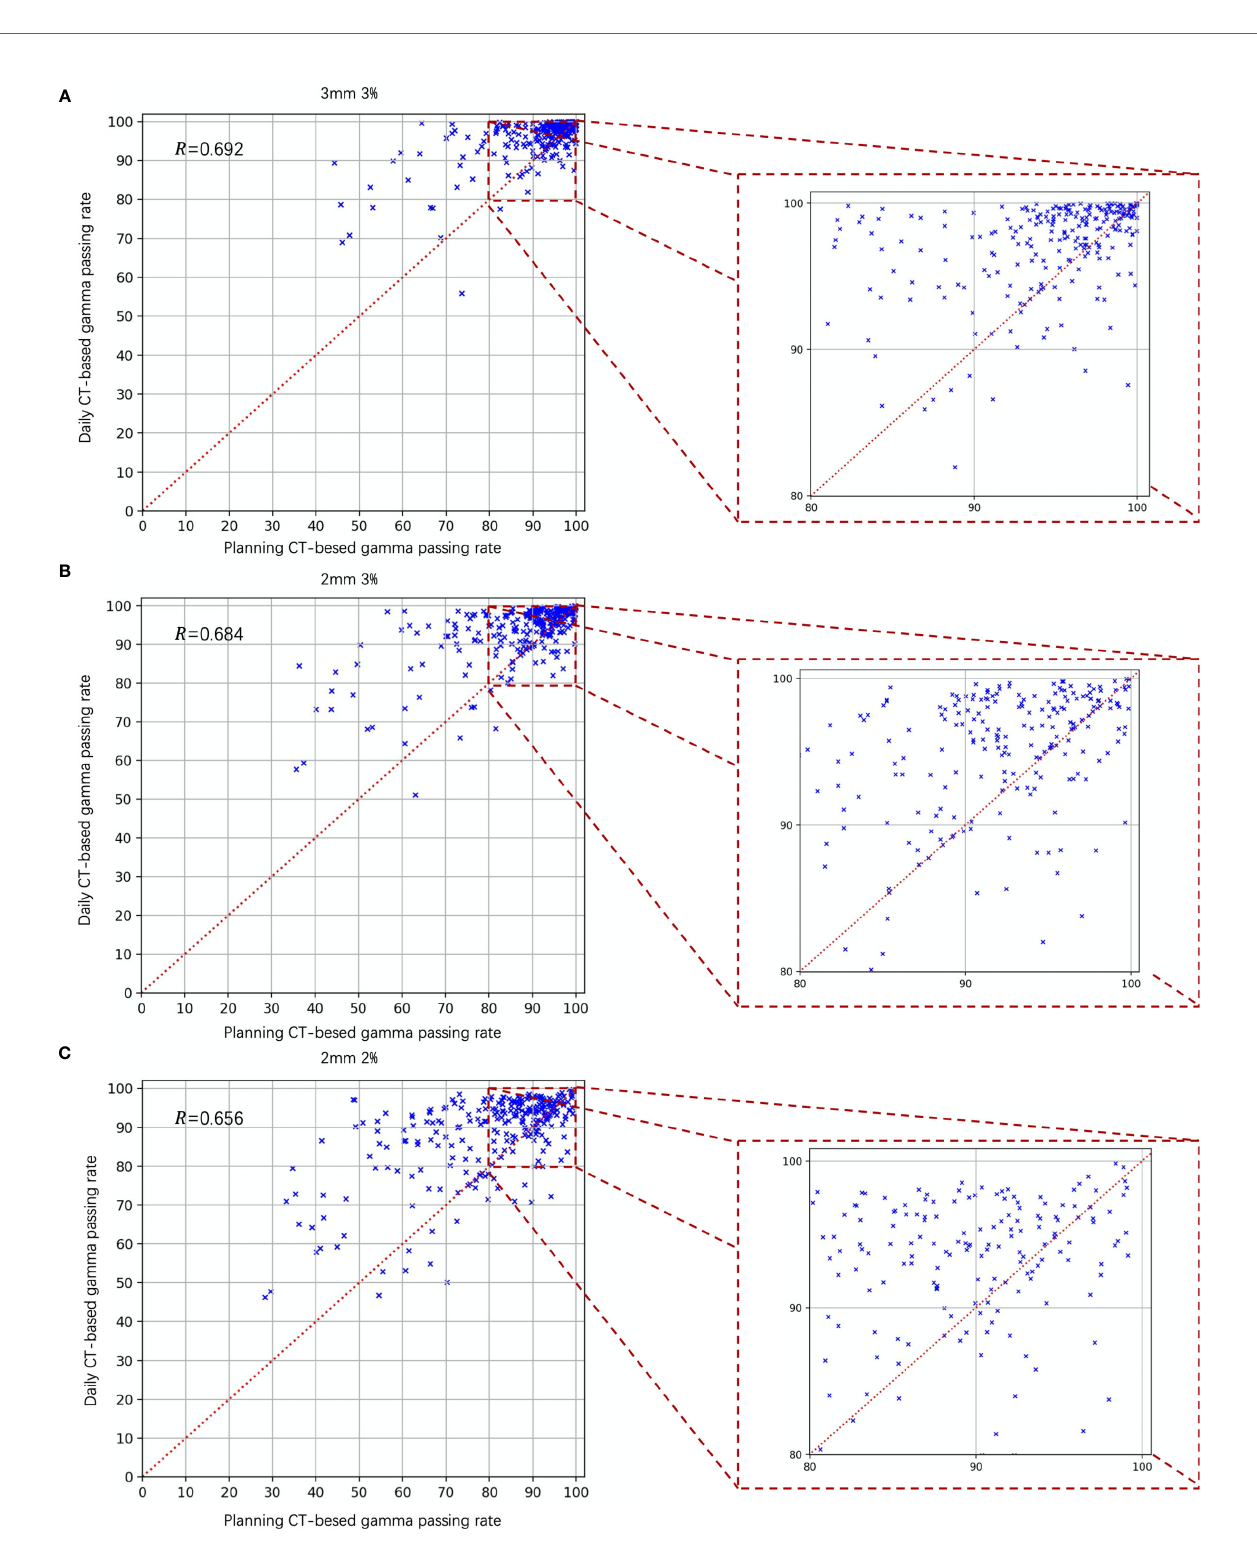
FIGURE 7 | Gamma analysis results of the daily CT-based vs. planning CT-based methods. The daily CT-based results indicate a higher gamma passing rate; (A) 3 mm 3%; (B) 2 mm 3%; and (C) 2 mm 2%.